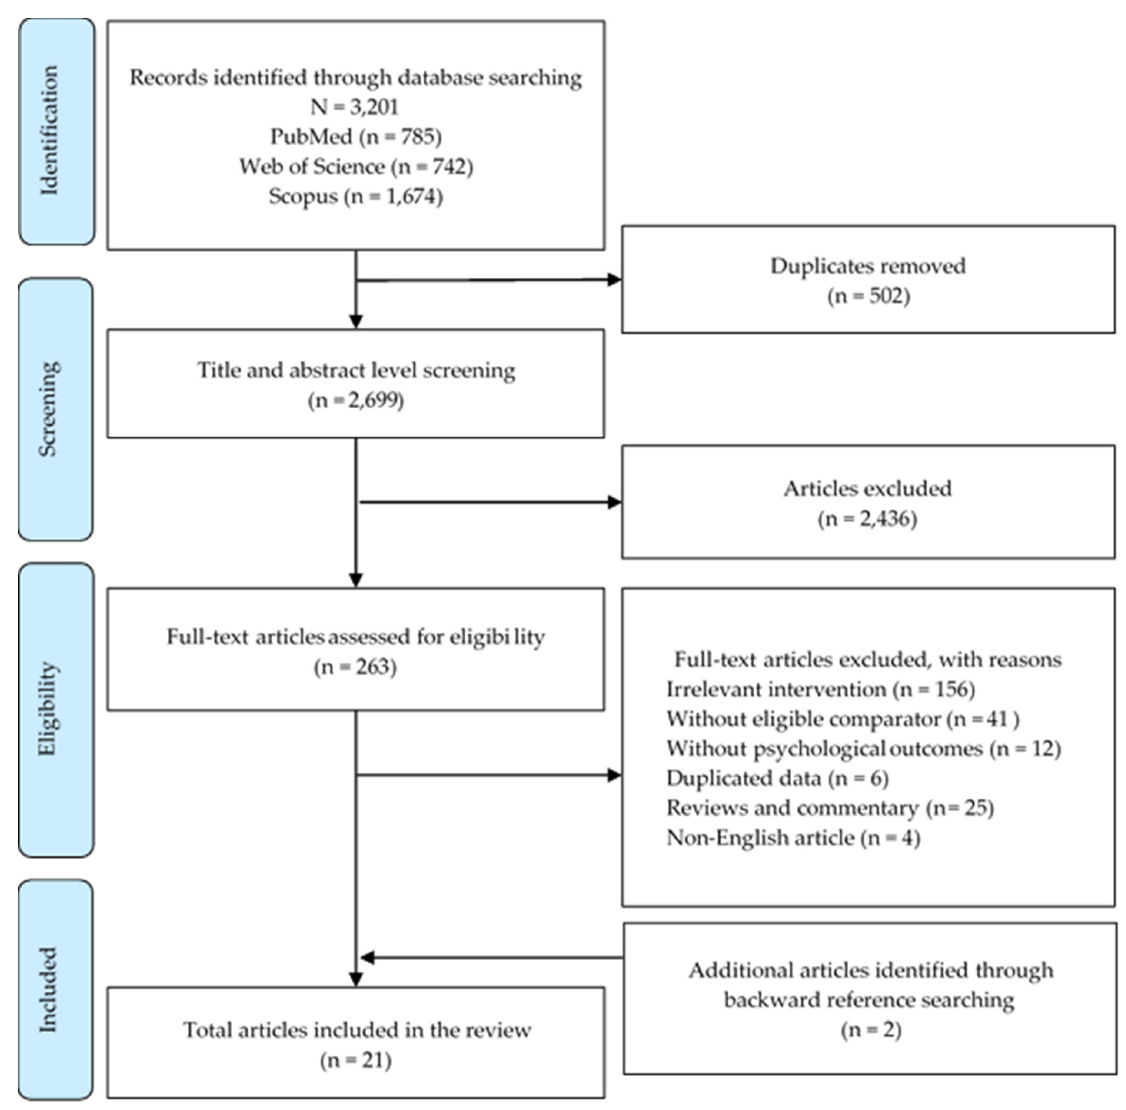
Figure 1. Flow diagram illustrating the selection